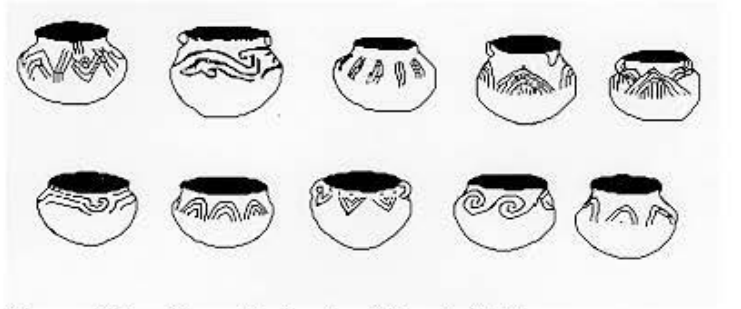
figure:\. Top Row: Varianu; of Oneota Potk"'Iy Bottom Row: Variants of Ramey Incised